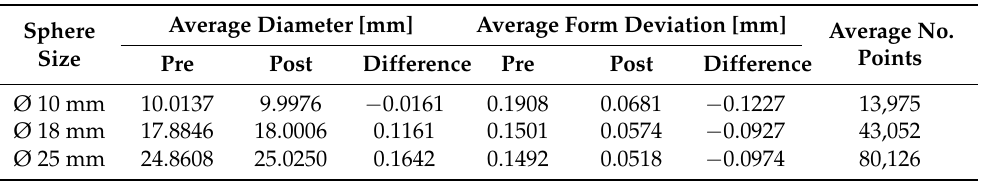
Table 3. Comparison of laser measurement results regarding diameter and form deviation pre- and